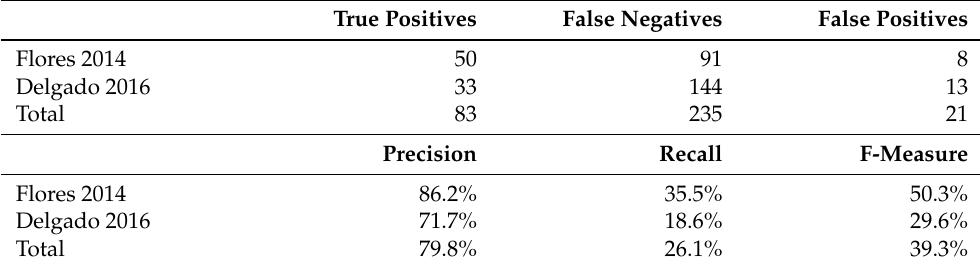
Table 5. Precision and recall for relation and action predicates computed on two papers. True Positives False Negatives False